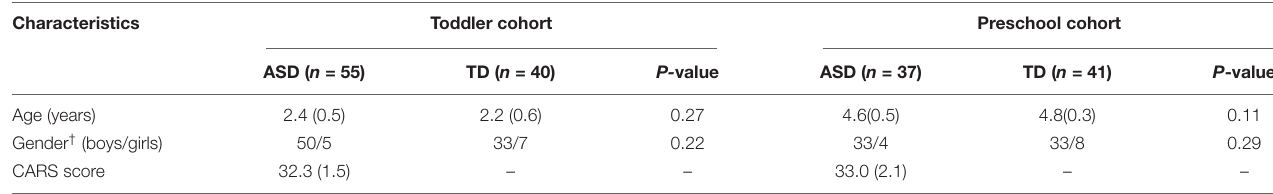
TABLE 1 | Demographic and clinical traits for all participants (mean ± SD).